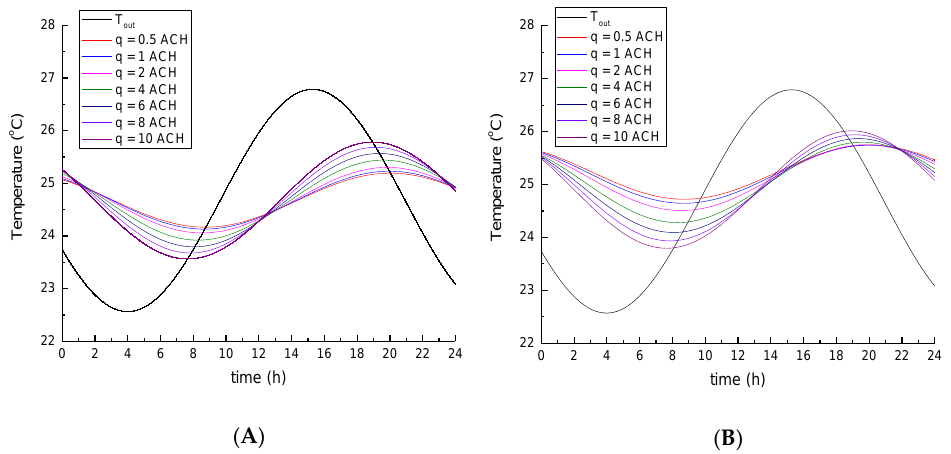
Figure 7. Indoor air temperature in the unoccupied home ( A ) and occupied home ( B ).